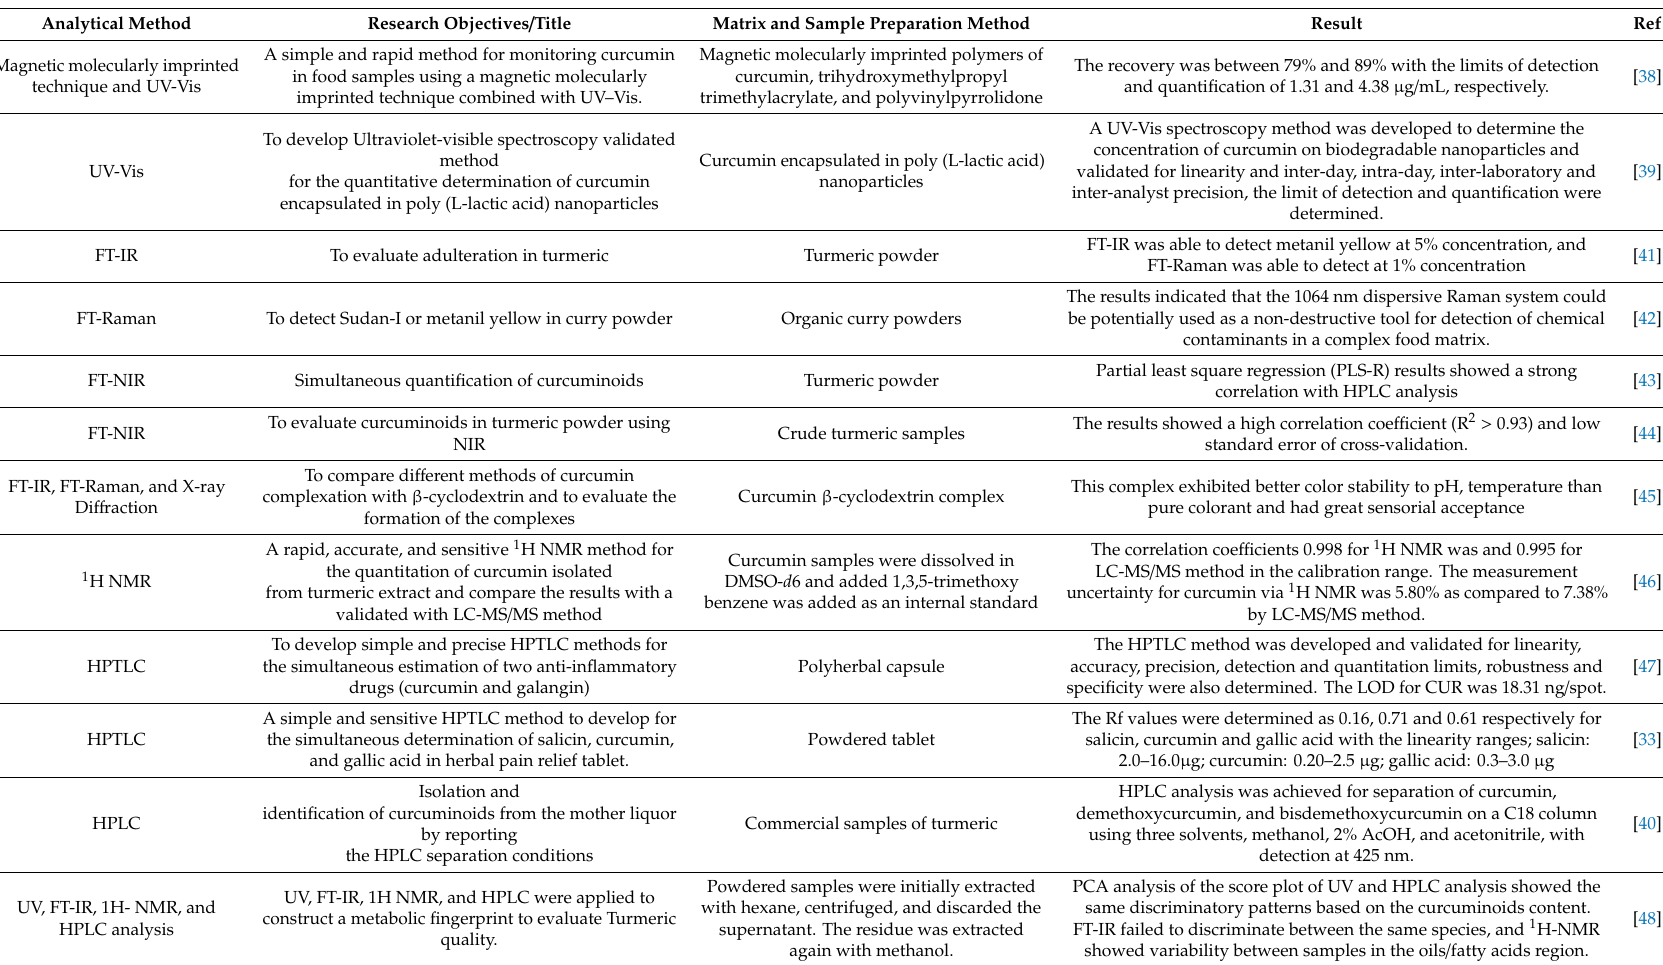
Table 3. A summary of recent literature on simple spectroscopic and chromatographic methods used for the assay of turmeric